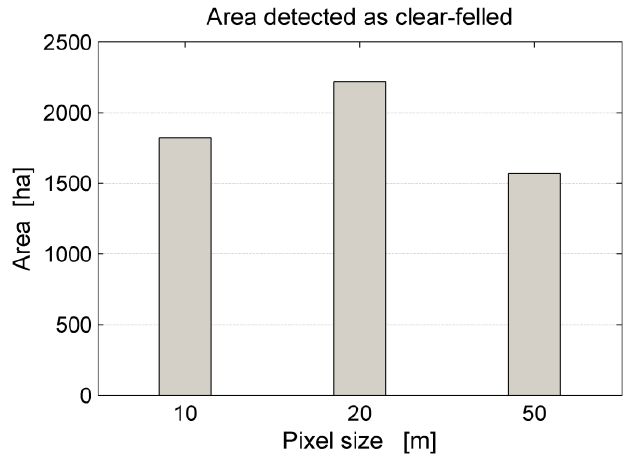
Figure 4. Total area detected as clear-felled for the 50 × 50 km 2 large region within the county of Västerbotten covered by the pair of ALOS PALSAR images available as path (10 m and 20 m pixel size) and strip (50 m pixel size) data. Image acquisition dates: 24 July 2007 and 10 September